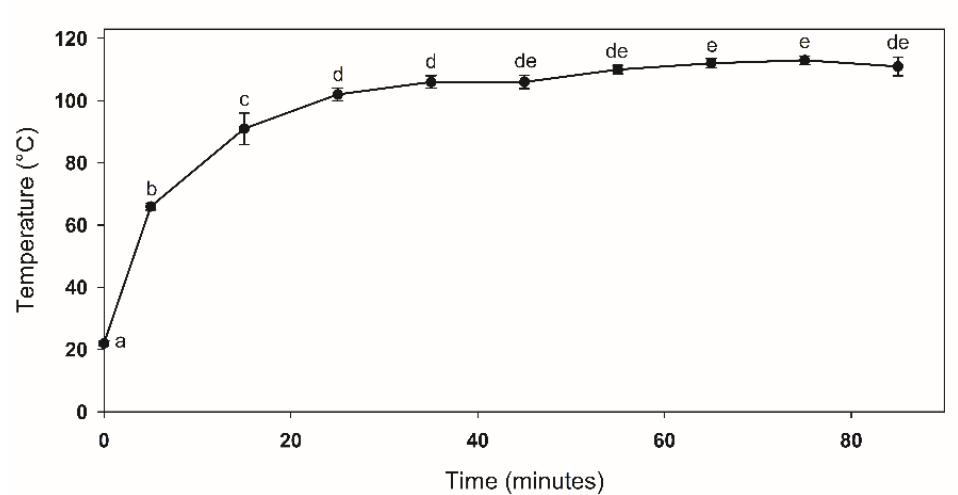
Figure 1. ( • ) Reaction temperature during ultrasonic irradiation according to the conditions: NaOH 65% (w / v), 90% amplitude, and sonication interval of 5–5 min (UC T7).